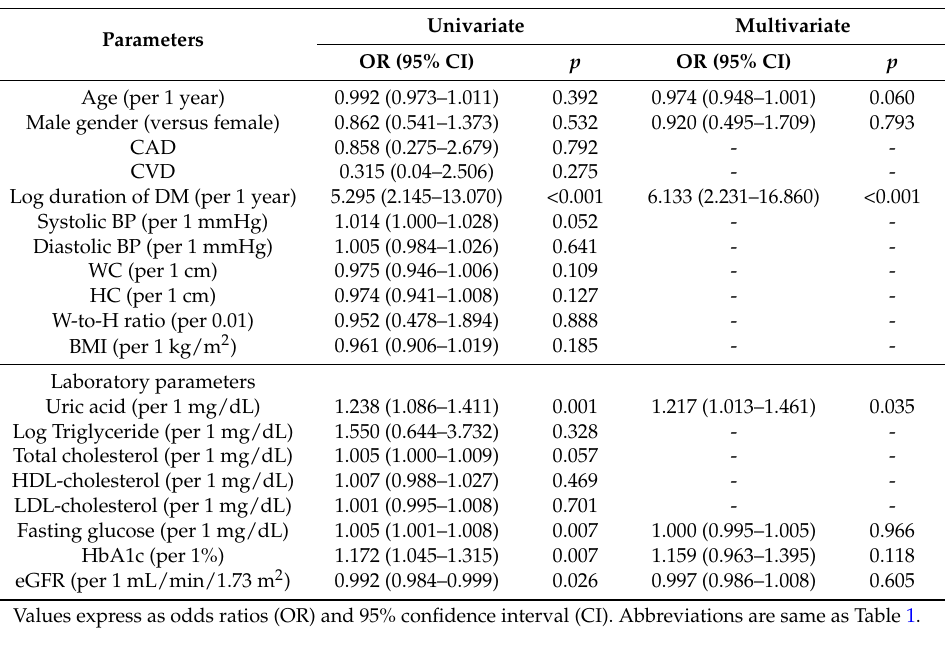
Table 3. Risk factors for diabetic retinopathy using binary logistic regression analysis. Parameters